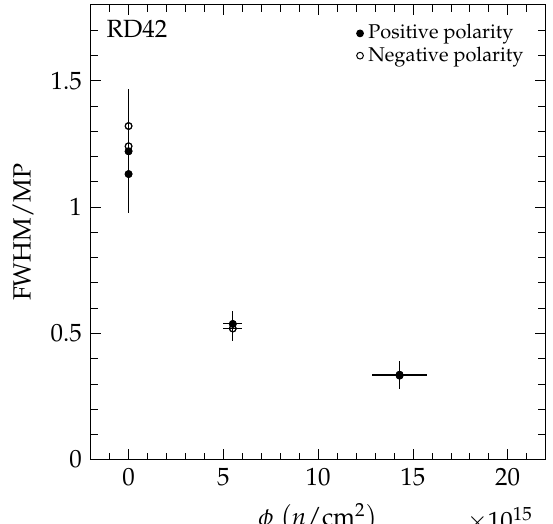
Figure 13. The FWHM/MP as a function of fluence in the fast neutron irradiation measured in a + 120GeV/ c hadron beam at CERN. The two values shown at each fluence are the values for positive (solid markers) and negative bias (open markers) at E =